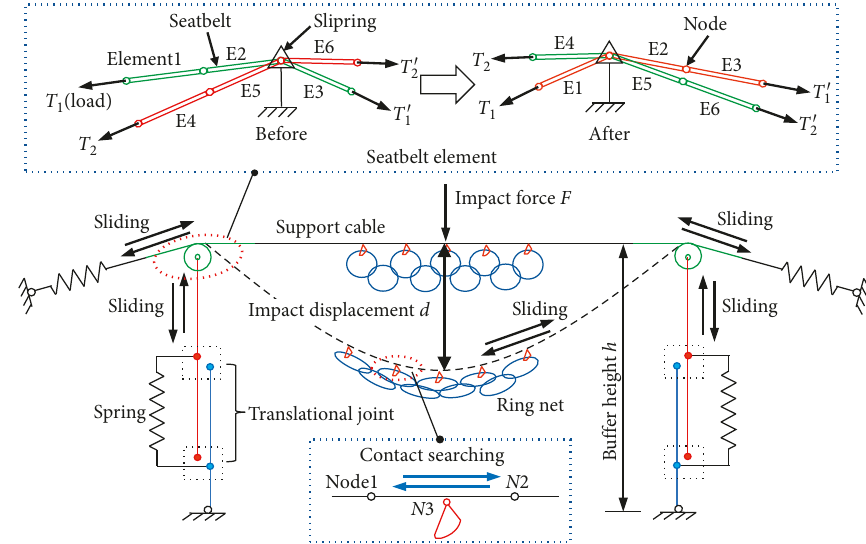
Figure 12: System dynamics model.